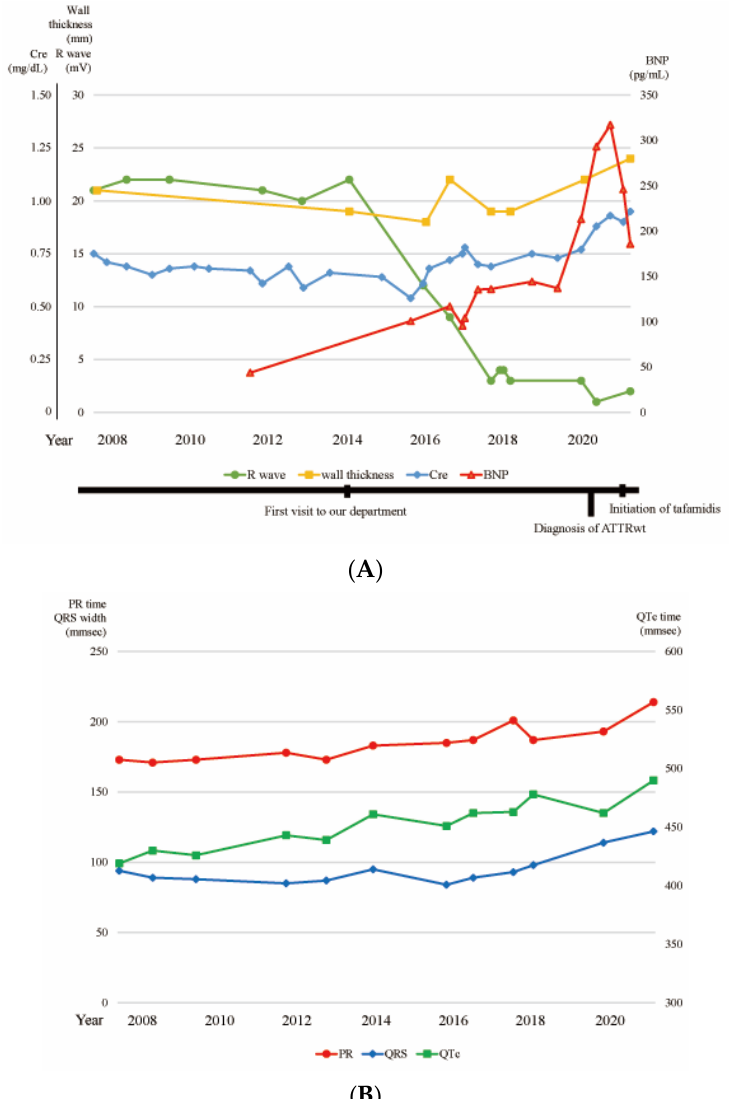
Figure 2. ( A ) Trends in the sums of the R waves in the V1–3 leads on electrocardiography (green line, ECG), the sums of the septal and posterior wall thickness on echocardiography (yellow line, UCG), the level of creatinine (blue line, Cre), and the level of B-type natriuretic peptide (red line, BNP). ( B ) Trends in PR time (red line), QRS width (blue line), and QTc time (green line).